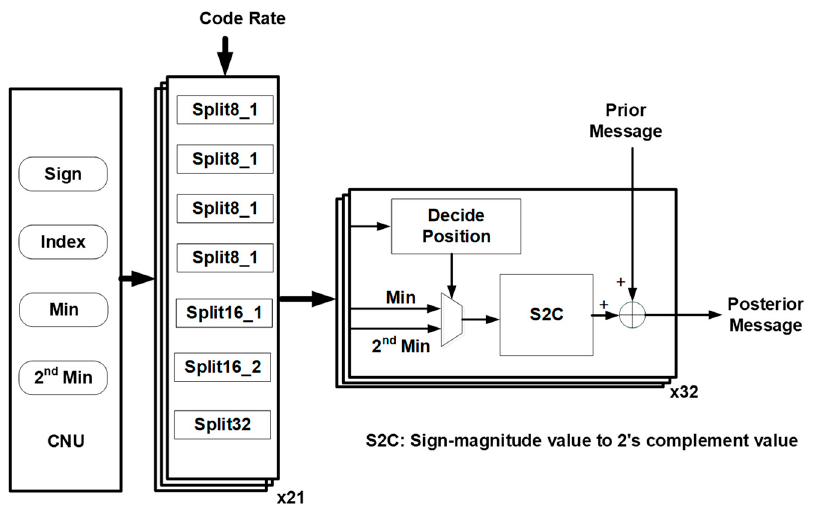
Figure 25. The architecture of the VNU.